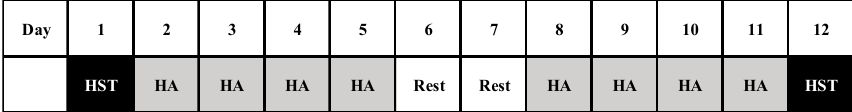
Figure 1. Overview of the study design. HST: heat stress test, HA: heat acclimation.